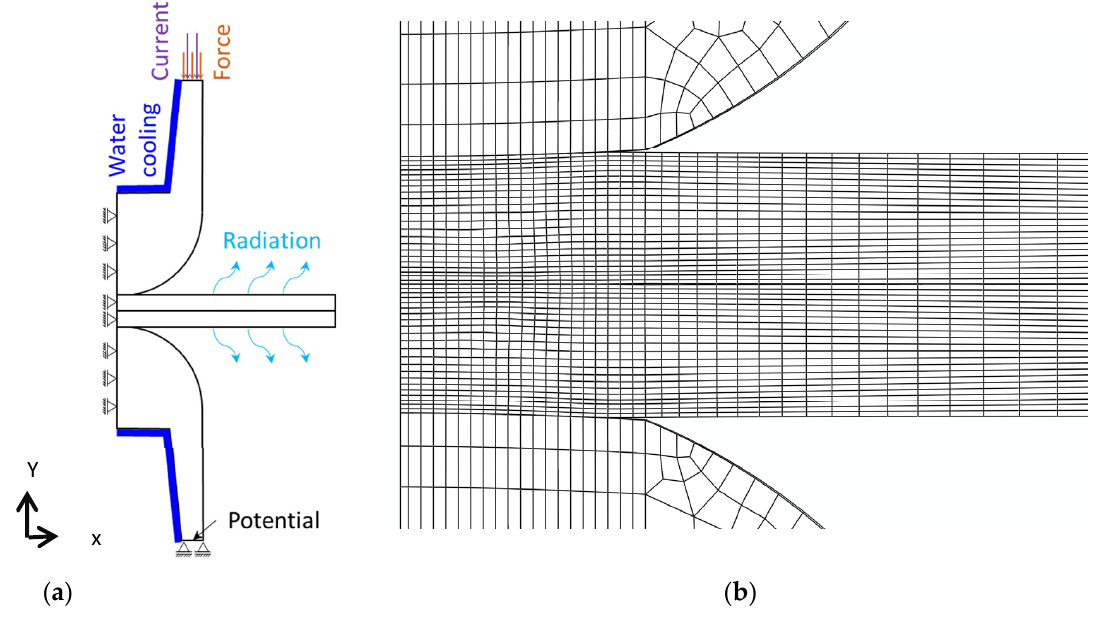
Figure 2. ( a ) A pplied boundary conditions and loadings, ( b ) mesh of a 2-sheet model. Figure 2. ( a ) Applied boundary conditions and loadings, ( b ) mesh of a 2-sheet